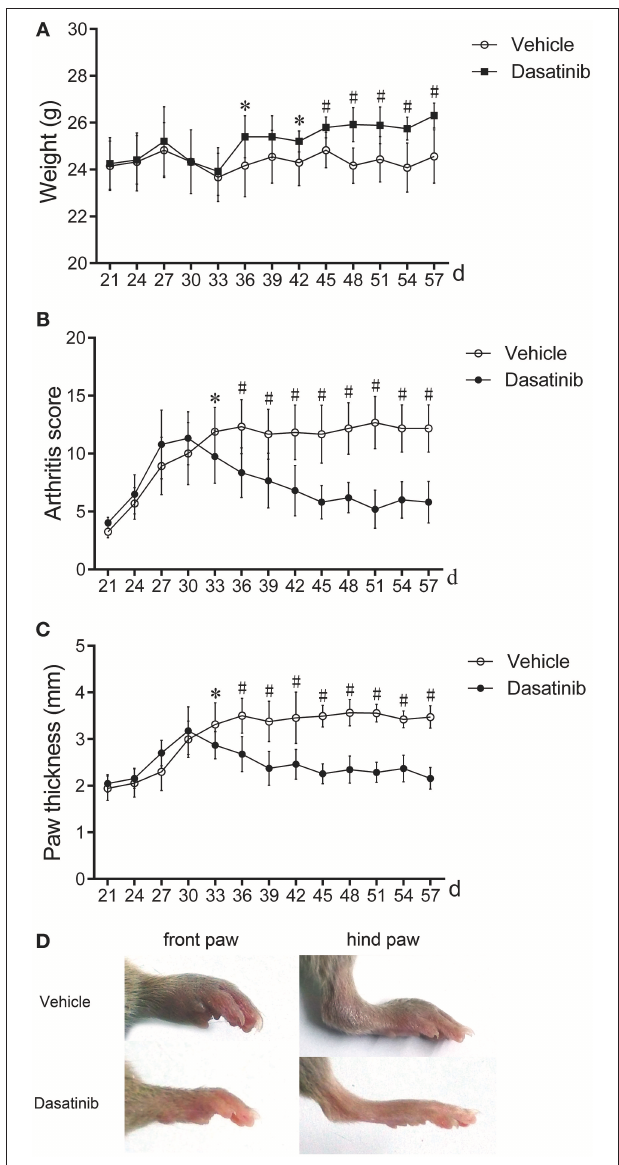
FIGURE 1 | Treatment with dasatinib attenuated the severity of arthritis in mice with CIA. DBA/1J mice were immunized twice with chicken CII150 µ g chicken type II collagen. Mice received gavage once daily from the 28th day to the 57th day with 10 mg/kg dasatinib and the same volume of control vehicle. All data are presented as the mean ± SEM. * P < 0.05, # P < 0.01 vs. vehicle group ( n = 9 per group). (A–C) Weight (A) , arthritis score (B) , and mean paw thickness (C) were calculated every 3 days from the 28th day to the 58th day after the first injection. (D) Macroscopic observations of the front and hind paws of mice on the 58th